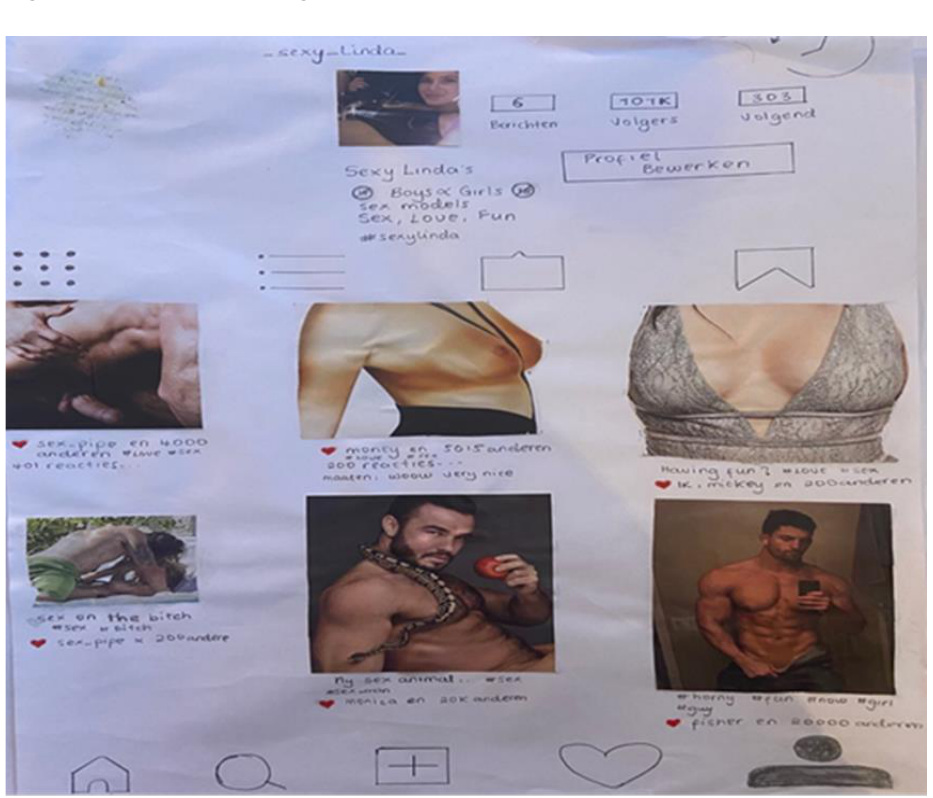
Figure 4: Linda - 'Bad'